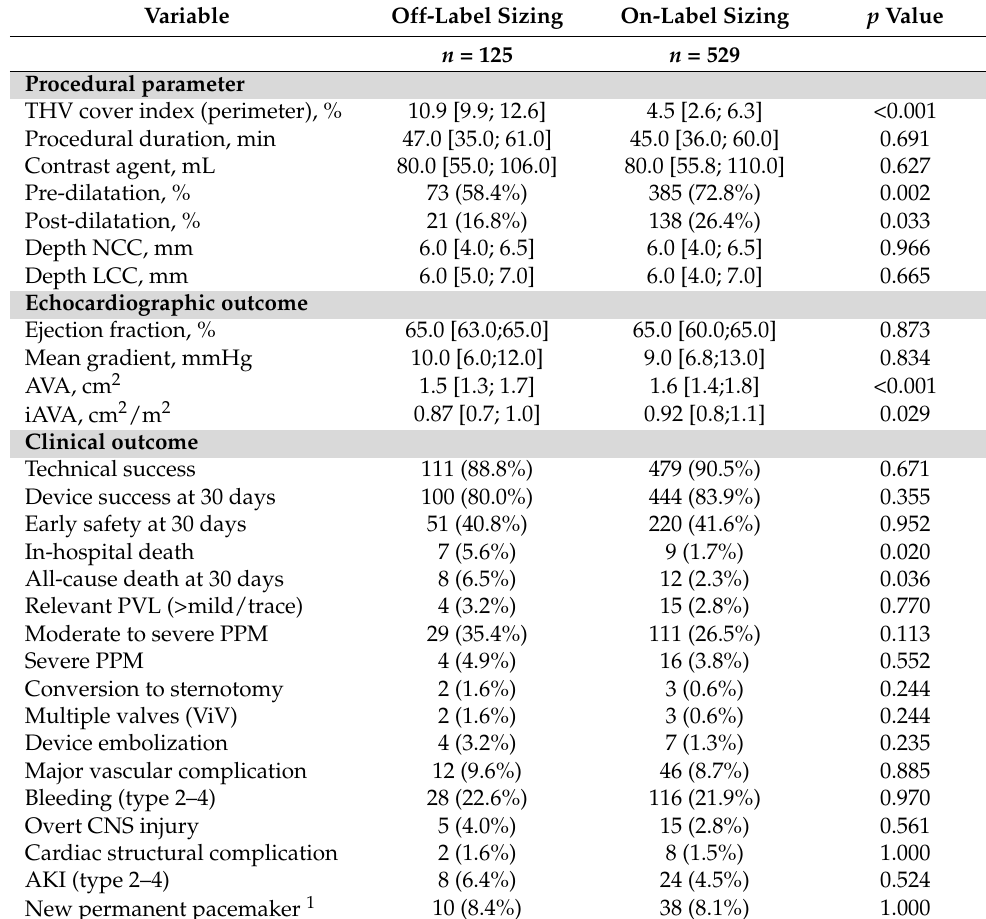
Table 2. Procedural outcomes and